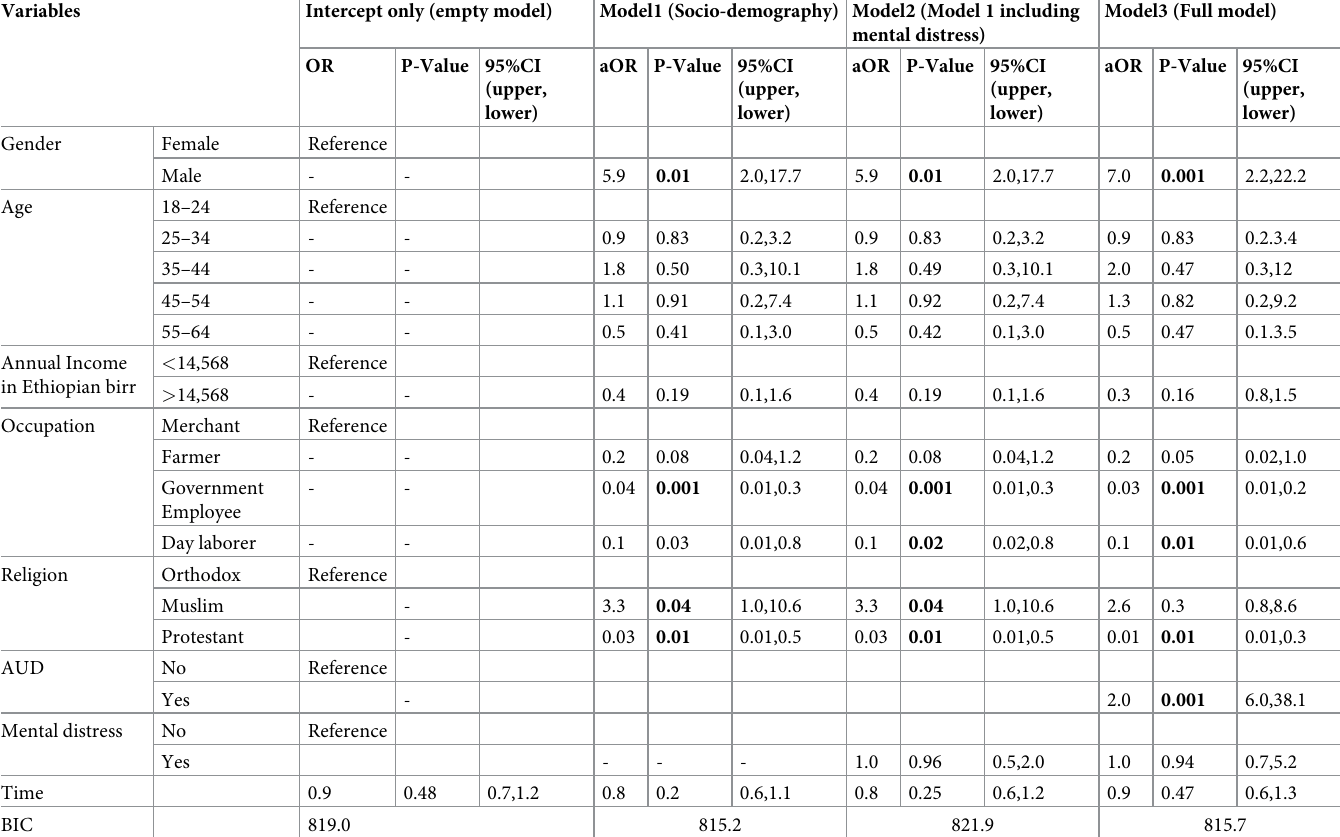
Table 2. Predictors of khat use among patients with tuberculosis in Southwest Ethiopia (n = 268) in 2017/18).